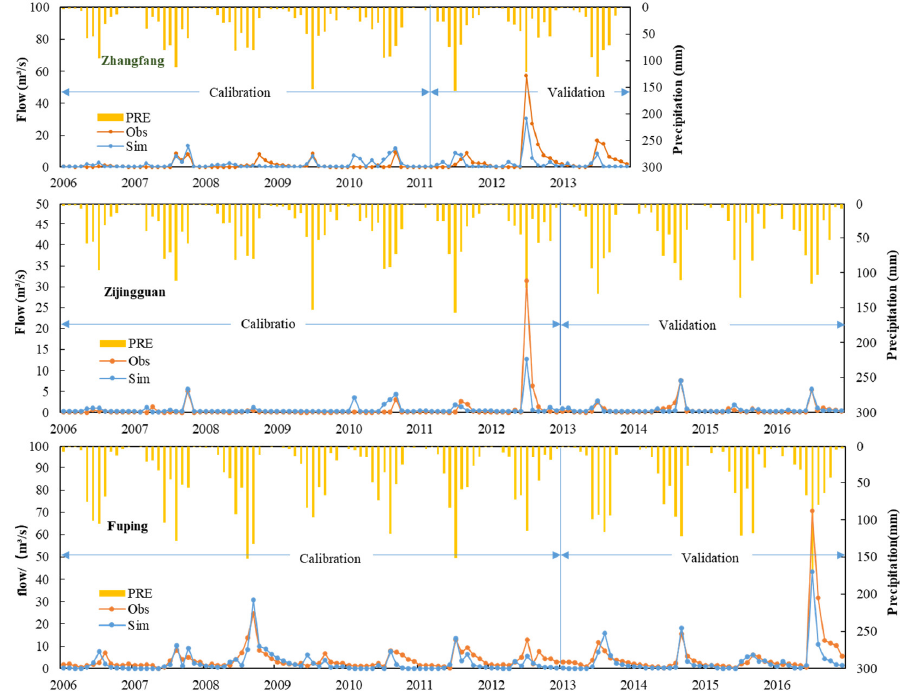
Figure 4. Measured and simulated values of runoff (stations in Zhangfang, Zijingguan, and Fuping).